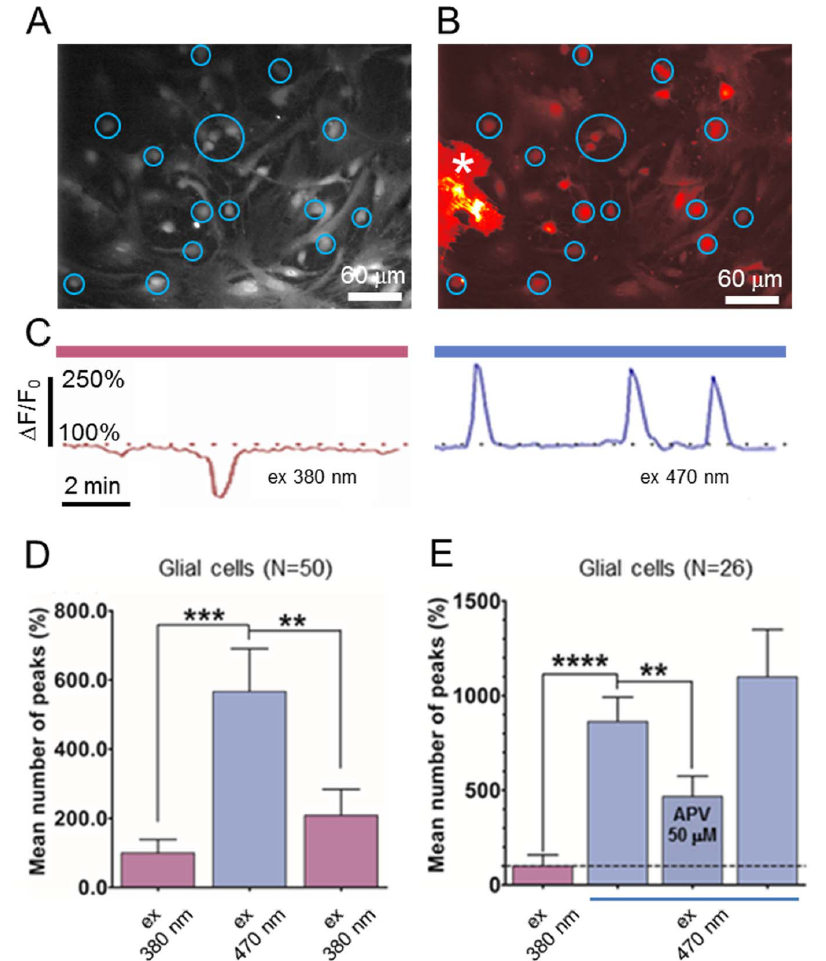
Figure 2. Stimulation ofChR2 positive astrocytesincreases glial cells calcium transients frequency. Cortical glial culture were co- incubated in fura-2-AM ( A ) and fluo-3-AM ( B ) and Ca 2 + transients were monitored during UV [excitation (ex)380 6 20 nm] and blue light [excitation (ex) 470 6 20 nm] stimulation (200 ms light pulse @ 0.5 Hz; 10 min UV R 10 min blue R 10 min UV). The star ( * ) indicates the ChR-2 positive astrocyte. C , Time course of ChR-2 negative astrocyte during UV (left panel) and blue (right panel) illumination. Fura-2 downward peak indicates [Ca 2 + ] i increase, fluo-3 upward peak indicates [Ca 2 + ] i increase. D , Stimulation of the ChR-2 positive astrocyte with 470 nm light (blue column)increased calcium waves frequency to 566.7% 6 124.2% (UV vs Blue, paired t test p=0.0002 – Blue vs UV, paired t test p=0.0048). E ,The increased Ca 2 + waves frequency mediated by stimulation of ChR2 positive astrocyte was significantly reduced by APV 50 m M (UV vs Blue, paired t test p , 0.0001 – Blue vs Blue + APV, paired t test p=0.0019). Values are means 6